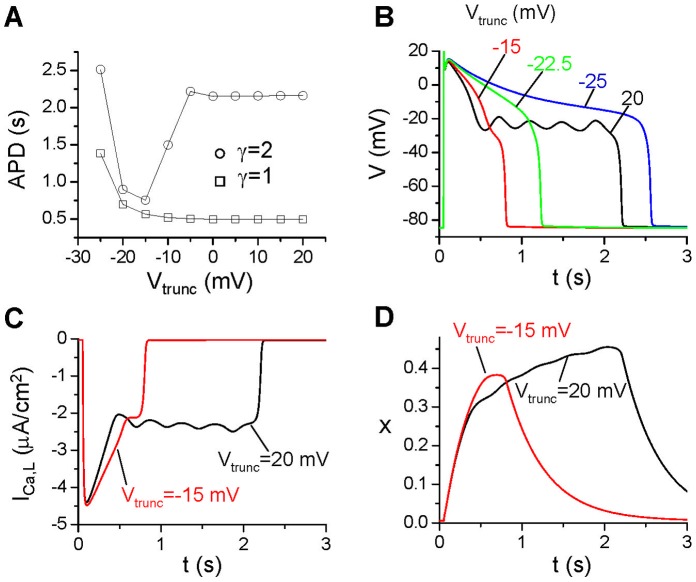
Effects of pedestal ICa,L.
A. APD vs Vtrunc for different γ.  = 0.15 mS/cm2. B. Action potentials for different Vtrunc for γ = 2. C. ICa,L vs time for Vtrunc = 20 mV and −15 mV. D. The activation gate x of IK vs. time for the two action potentials in C.